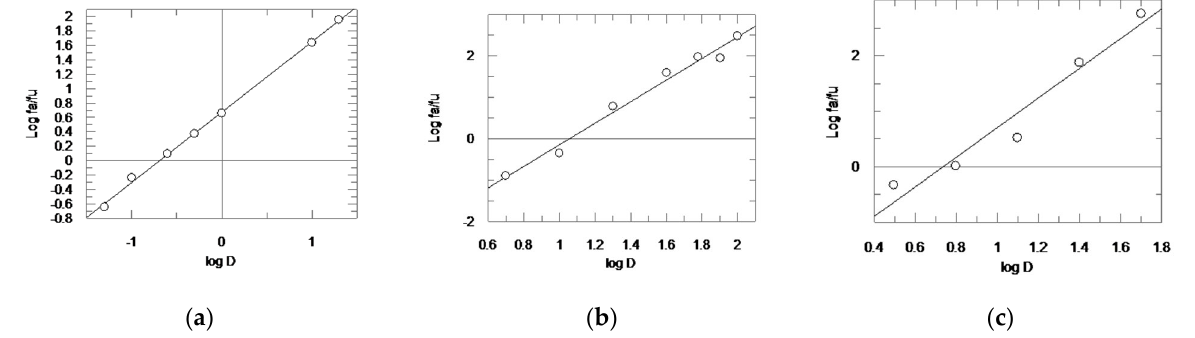
Figure 3. Median effect plot for CD24 ( a ), curcumin ( b ), and CD24 + curcumin in combination (molar ratio 1:62) ( c ). D is the dose, and f a and f u are the affected and the unaffected fraction of rhodesain activity, respectively, by dose